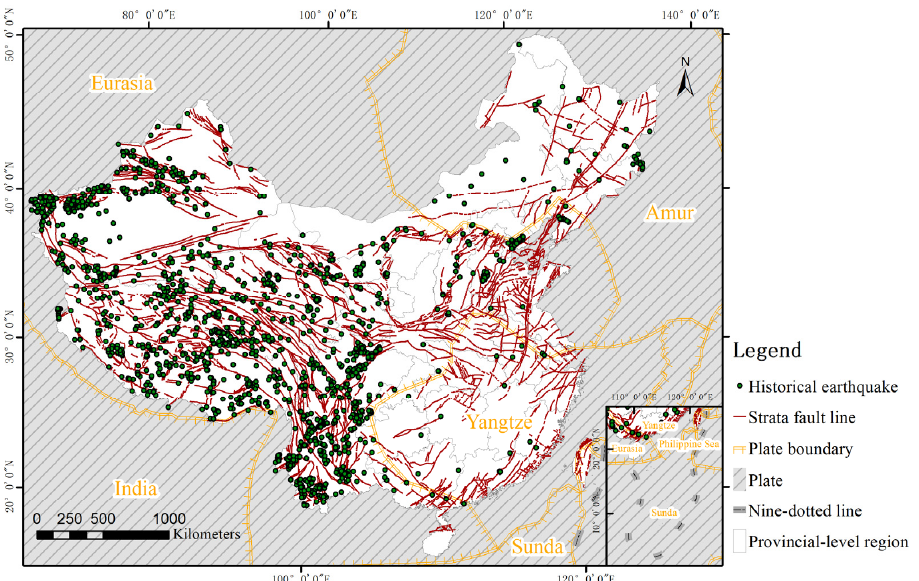
Figure 1. Historical earthquakes and plate distribution in China’s mainland; nine-dotted line is the boundary of China’s territory in the South China sea.